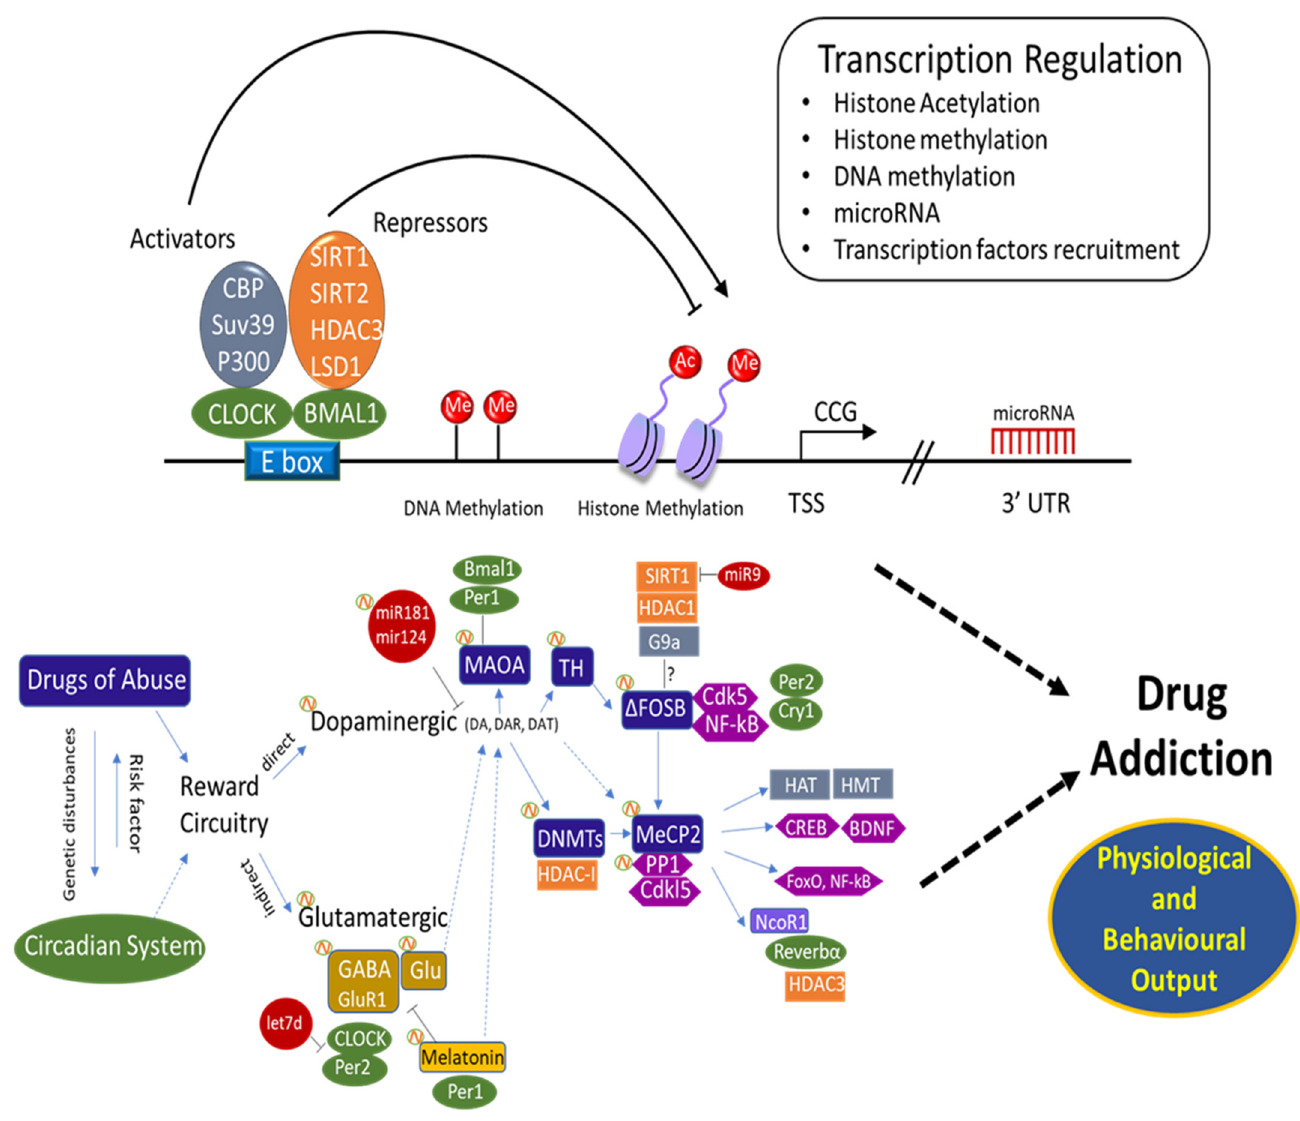
Figure 1. Circadian epigenome and reward circuitry in addiction. A schematic representation of the core clock machinery is shown. The activating heterodimer CLOCK:BMAL1 binds to the E-box elements on the genome, controlling a large number of genes. CLOCK:BMAL1 action is counteracted by the PER and CRY repressor proteins. Additional regulators and chromatin remodelers contribute to circadian gene expression. Among the genes controlled by the clock, a number of them are key reward system regulators. The molecular clock has also been shown to interplay with several transcription activators and repressors complex genes.